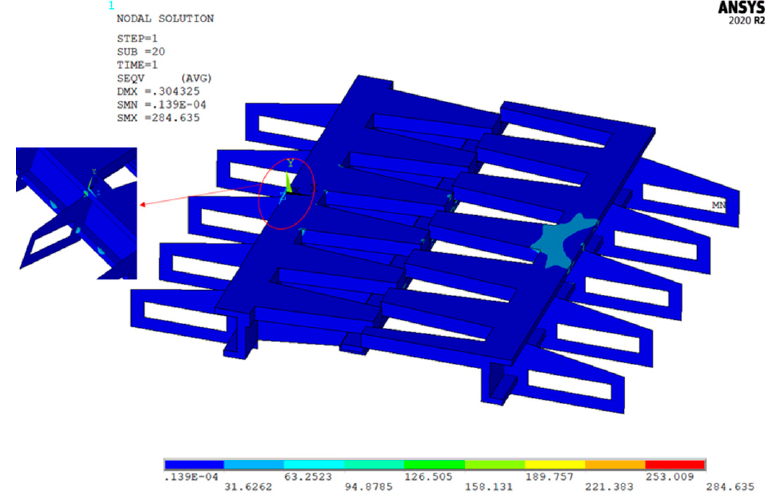
Figure 7. Equivalent stress diagram of the structure under working condition II. Table 2. Results of the equivalent stress of the structure.